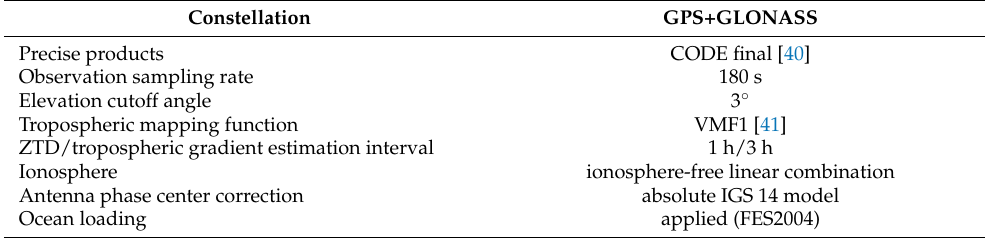
Table 4. Basic settings of final GNSS data processing.